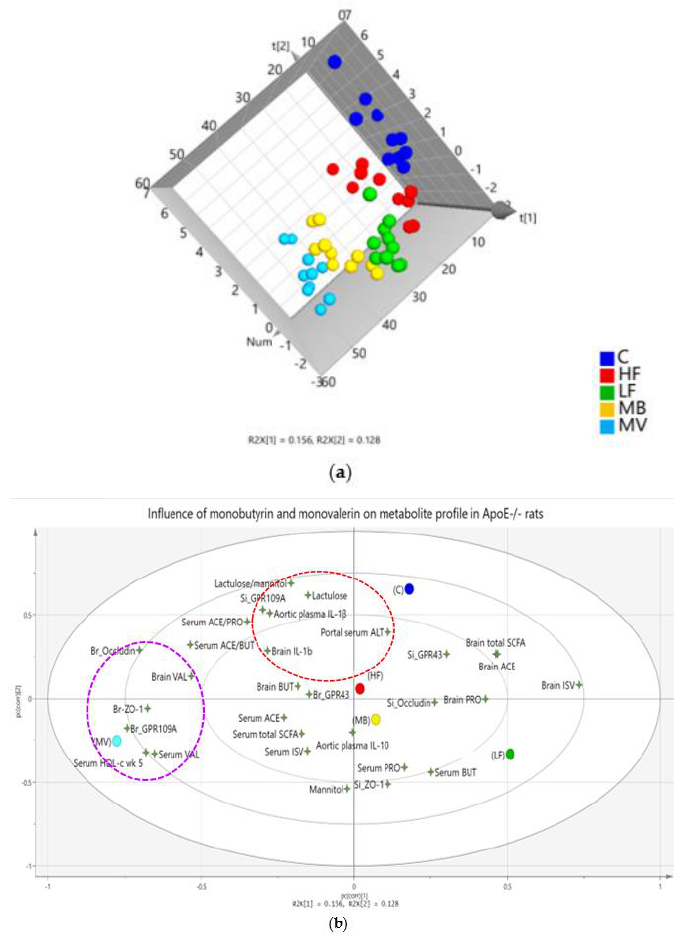
Figure 5. Projection to Latent Structures-Discriminant Analysis (PLS-DA) plot summaries of the e ff ects of monobutyrin (MB) and monovalerin (MV) on short-chain fatty acids (SCFAs) and biomarkers in conventional rats fed a pure high-fat diet (C), or Apolipoprotein E-knockout (ApoE- / -) rats fed a low-fat diet (LF) or high-fat diet, pure (HF) or supplemented with 1% MB or MV for 5 weeks. ( a ) The score scatter plot shows separation patterns among the groups, with each circle denoting one rat having all values of the variables included in the loading plot; ( b ) alterations of the measured variables (shown as 4-angle stars) as an e ff ect of the experimental diets (shown as circles). ACE, acetic acid; BUT, butyric acid; PRO, propionic acid; ISV, isovaleric acid; VAL, valeric acid; ALT, alanine transaminase, IL, interleukin; HDL-c, high-density lipoprotein cholesterol; br, brain; si; small intestine; ZO-1, zonula occludens-1; GPR, G-protein-coupled